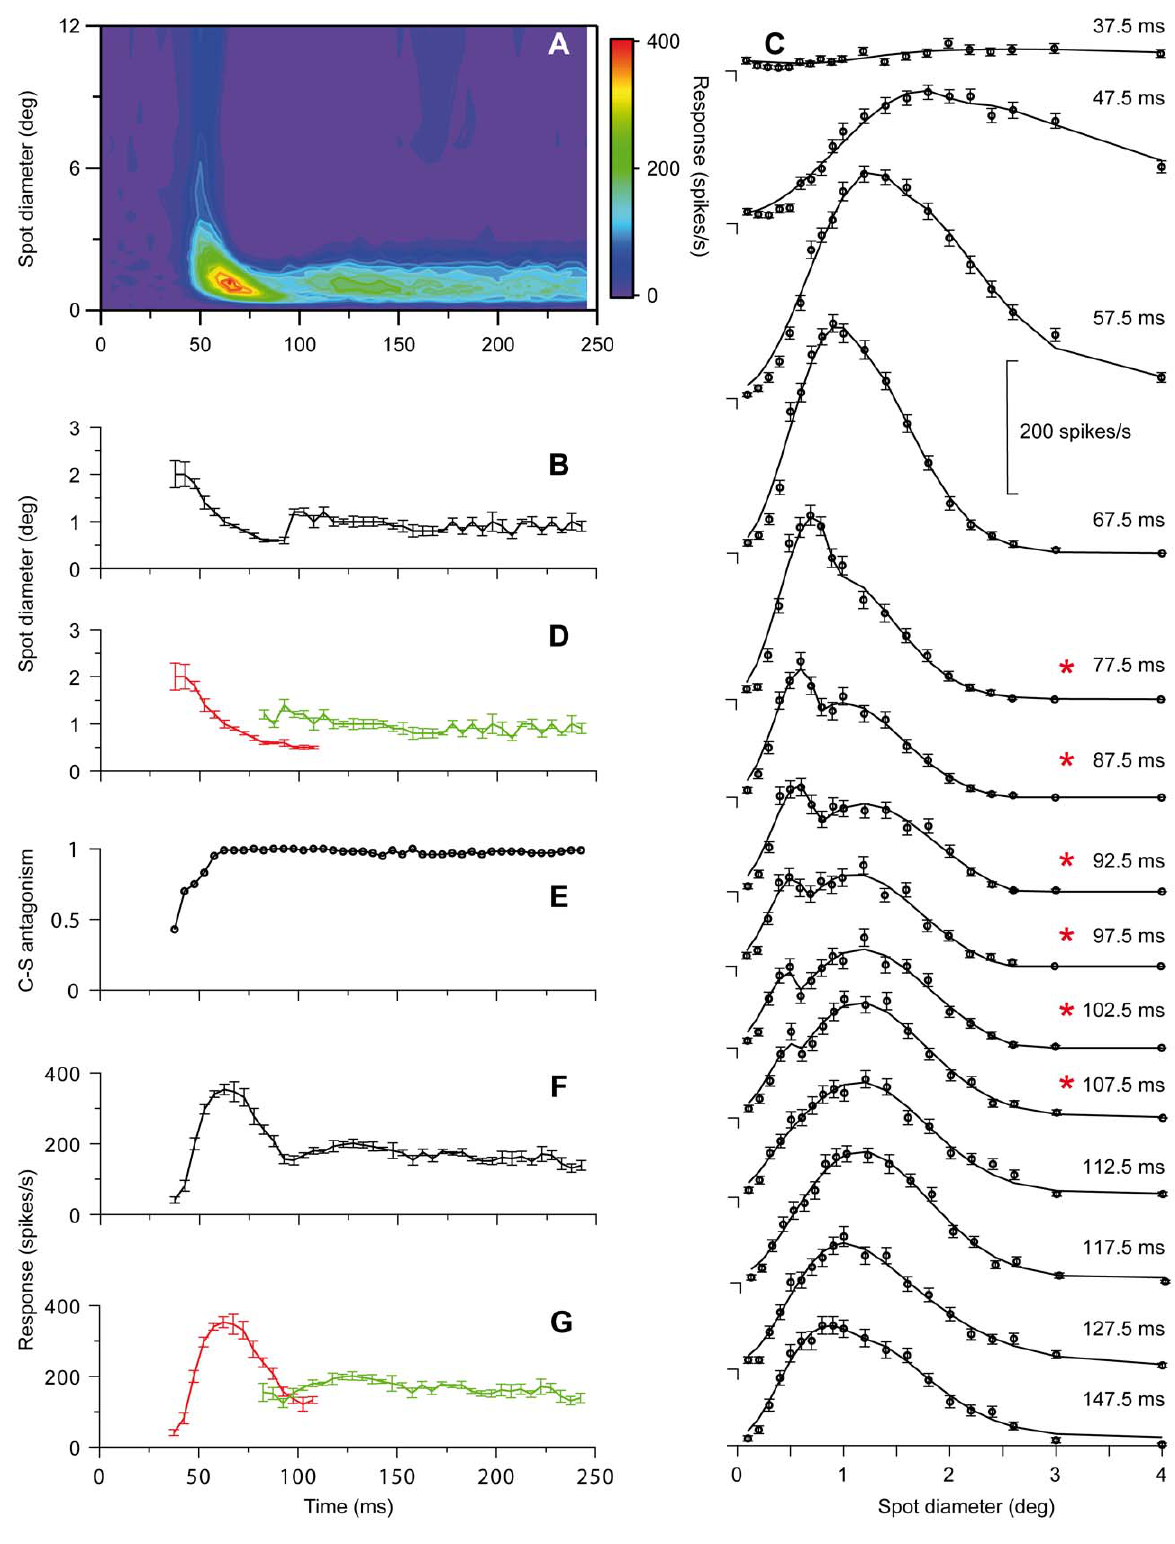
Figure 2. RF dynamics for an on-center X-neuron. Similar plots as for the Y-neuron in Fig. 1. Number of presentations of each spot 125.